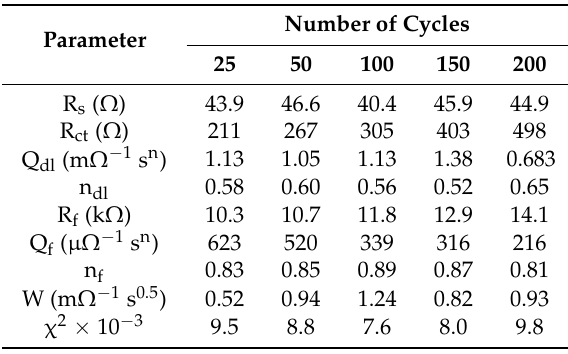
Table 2. Parameters obtained from electrochemical impedance spectroscopy data simulation for poly-(4-HPA)/GE platforms modified with different numbers of cycles using the equivalent circuit proposed (mean, n = 3).